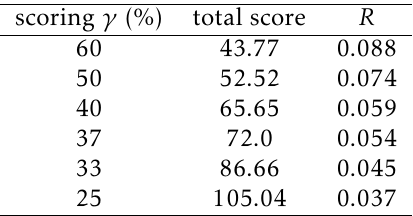
Table 8. Some statistics for side-out system with 15 points (simulation).